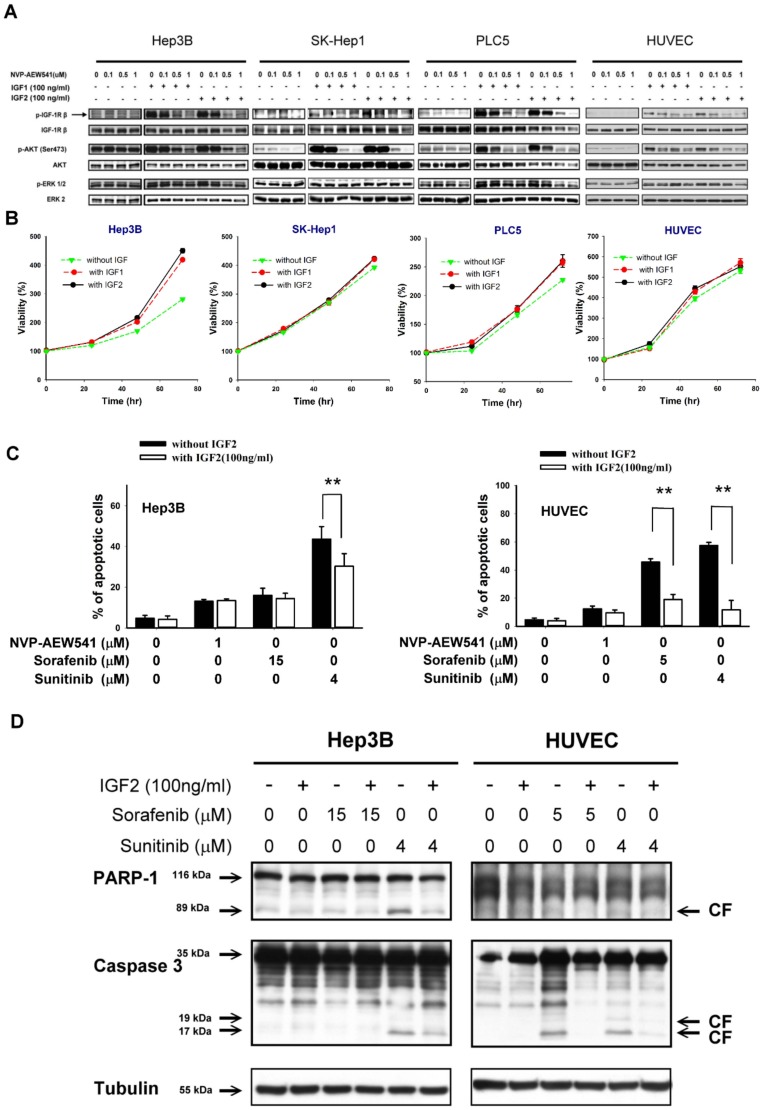
Effects of IGFR signaling modulation on drug resistance of HCC cells.(A) Addition of IGF1 or IGF2 (100 ng/ml) into the culture medium can activate IGFR and AKT signaling in all the HCC cells (Hep3B, SK-Hep1, and PLC5) and HUVEC. The activation can be inhibited by the IGFR inhibitor NVP-AEW54. (B) Growth curves of HCC cells and HUVEC with or without stimulation by IGF1 or IGF2. Cell viability was assessed by MTT assay. Points, mean (n = 3); bars, SD. (C) Percentage of apoptotic cells was measured by flow cytometry after 72 hours of drug treatment in Hep3B and HUVEC. **, p<0.05 compared with cells untreated with IGF2. (D) Effects of IGF stimulation on sorafenib, and sunitinib on P ARP-1 cleavage and caspase 3 activation.